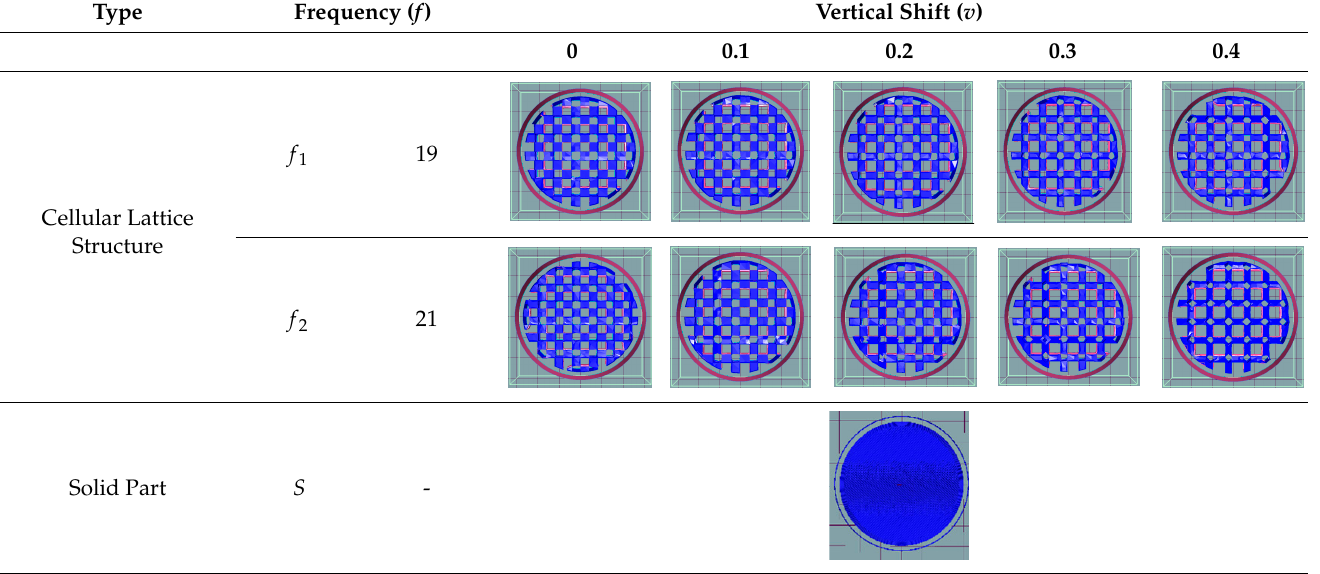
Table 5. X-sectional views of the test specimens constructed through Algorithm 1, given above.